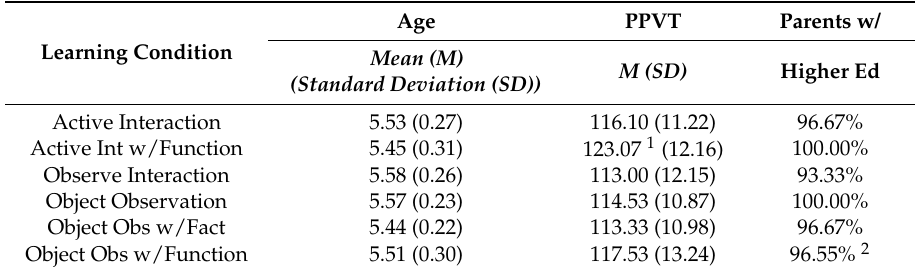
Table 1. Descriptive statistics for participants in Experiment